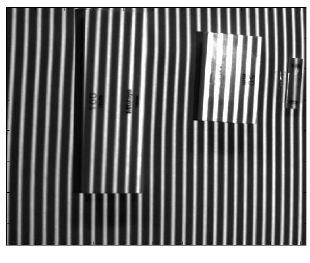
Figure 11. One of the acquired images.